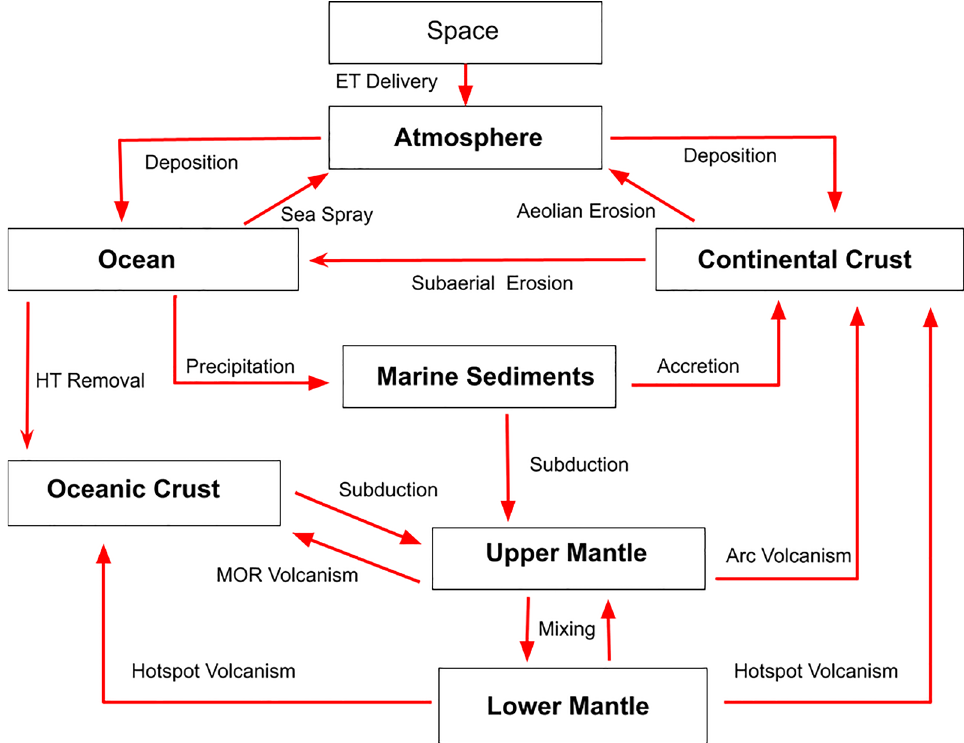
Figure 1. Reservoirs (boxes) and fluxes (arrows) considered in this global box model. The reservoirs are abbreviated in the text as follows: continental crust (CC), marine sediments (MS), oceanic crust (OC), upper mantle (UM), lower mantle (LM).